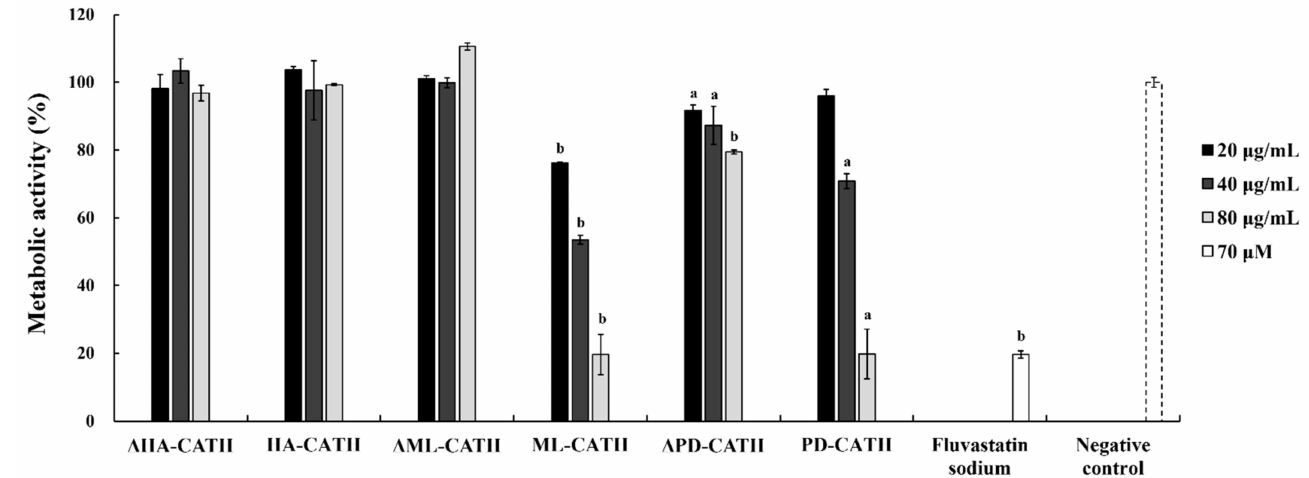
Figure 1. Metabolic activity after the addition of bat cathelicidin-derived peptides against Mucor hiemalis KCTC 26779. ∆ HA-CATH, ∆ ML-CATH, and ∆ PD-CATH are the predicted antimi- crobial activity core region peptides of Hipposideros armiger (accession number, XP_019486615.1), Myotis lucifugus (accession number, XP_006108360.2), and Phyllostomus discolor (accession number, XP_028374415.1) cathelicidins, respectively. HA-CATH, ML-CATH, and PD-CATH are the predicted nascent mature region peptides. Statistical significance was indicated above bars; a ( p < 0.01) and b ( p < 0.001).